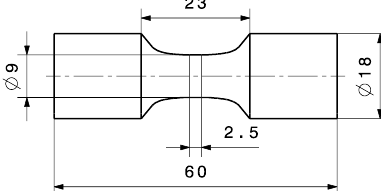
Figure 2. High cycle fatigue (HCF) specimen A with dimensions in [mm].